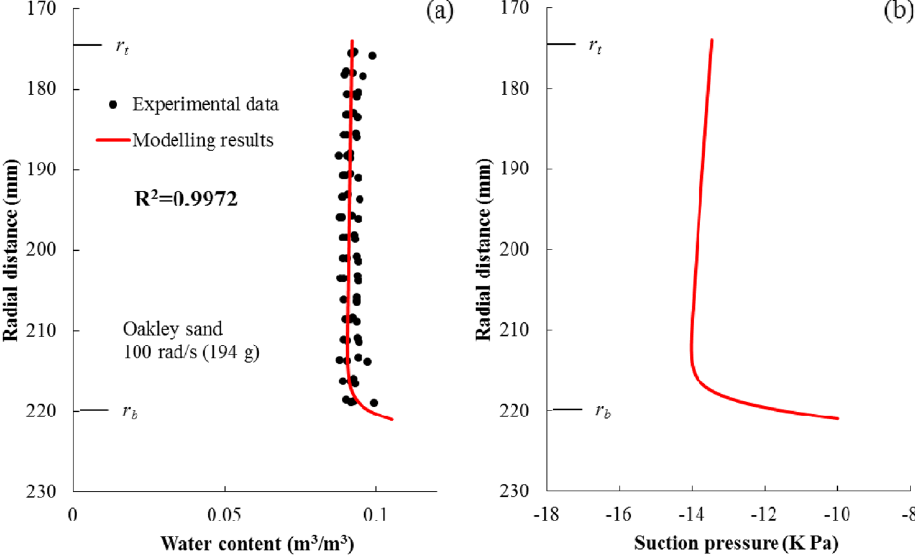
Figure 5. Simulation of soil moisture content profiles under steady-state condition: ( a ) moisture content profile predicted by the numerical model and comparison with data from Nimmo et al. 22 , ( b ) predicted suction profile. The coefficient of determination (R 2 ) is also listed in the